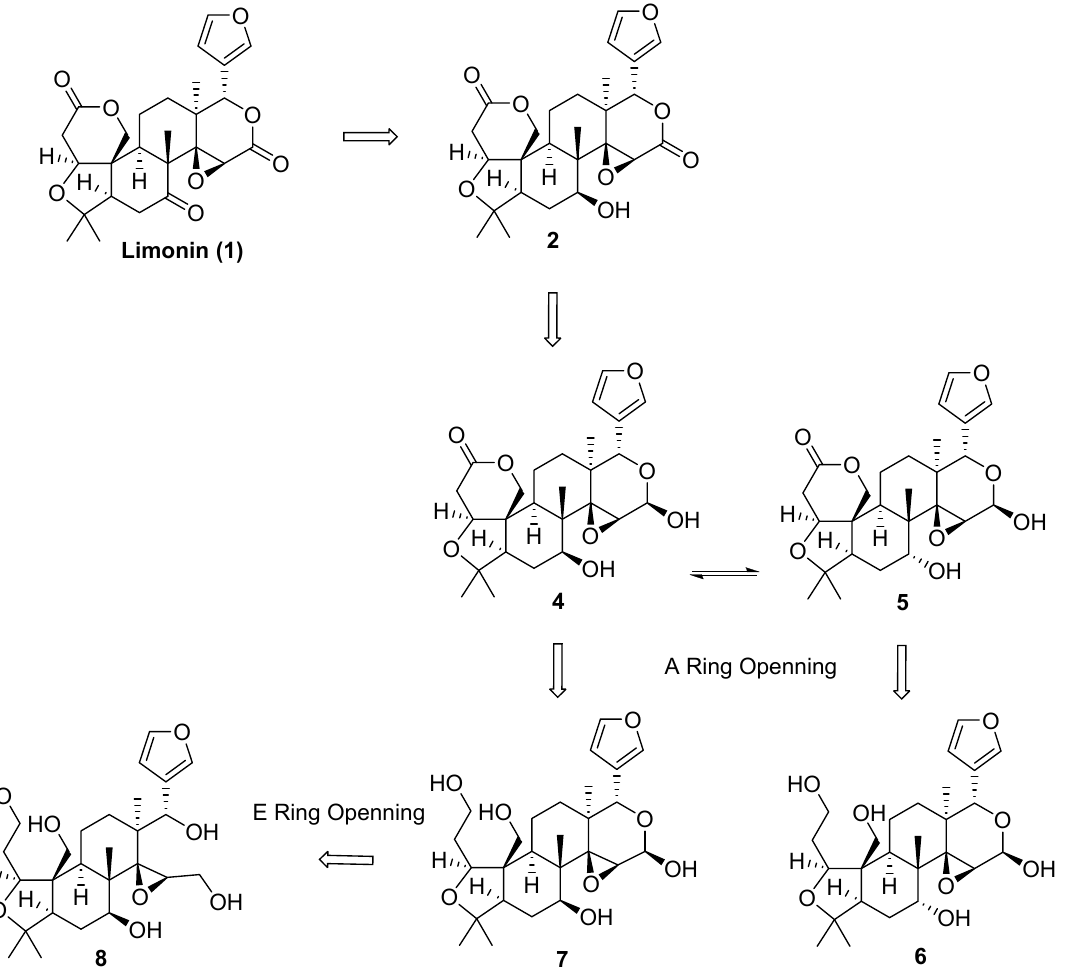
Figure 5. Hydrogenation of limonin by sodium borohydride.